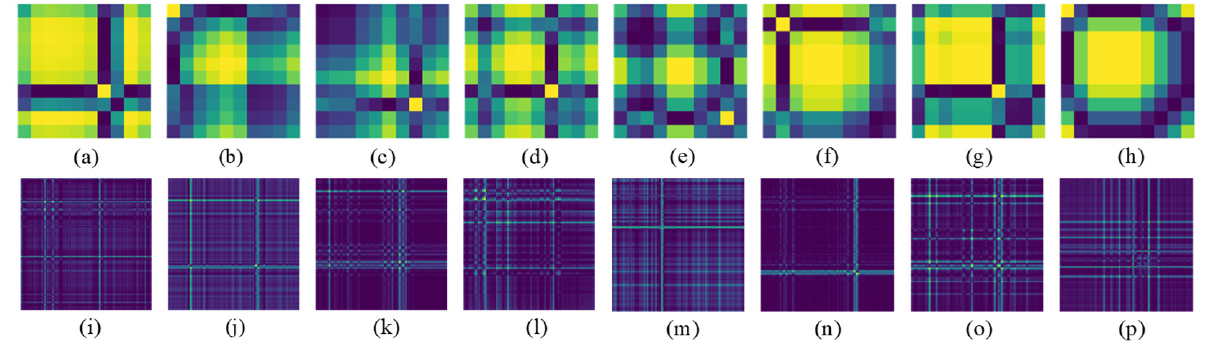
Figure 6. Demonstration of sEMG-GAF images of different gestures from NinaPro DB1 dataset ( a – h ) and CapgMyo DB-a dataset ( i – p ) on the specified moment. The gestures include thumb up as shown in ( a ) and ( i ), extension of index and middle, flexion of the others as shown in ( b ) and ( j ), flexion of ring and little finger, extension of the others as shown in ( c ) and ( k ), thumb opposing base of little finger as shown in ( d ) and ( l ), abduction of all fingers as shown in ( e ) and ( m ), fingers flexed together in a fist as shown in ( f ) and ( n ), pointing index as shown in ( g ) and ( o ), and adduction of extended fingers as shown in ( h ) and ( p ). The different colors in sEMG-GAF images indicate relationships between the instant values in different sensors. The color difference between the images of different gestures indicates the degree of differentiation of gestures.